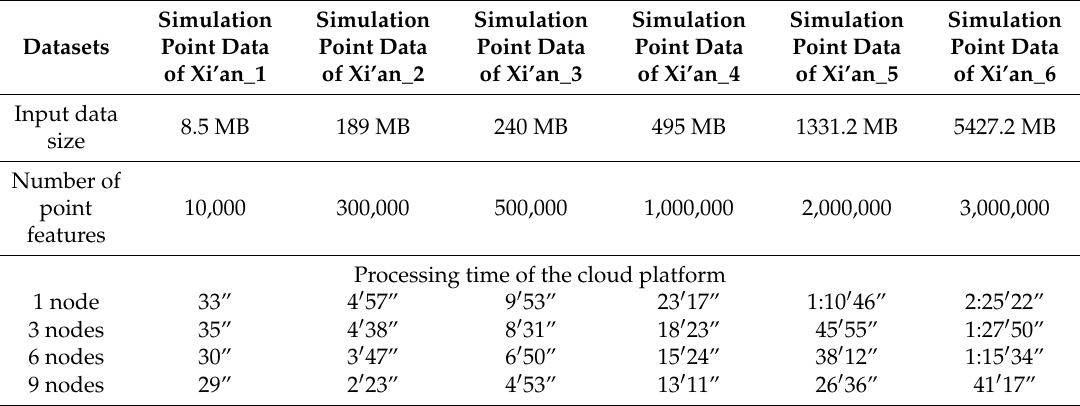
Table 4. Processing time of point generalization with different data